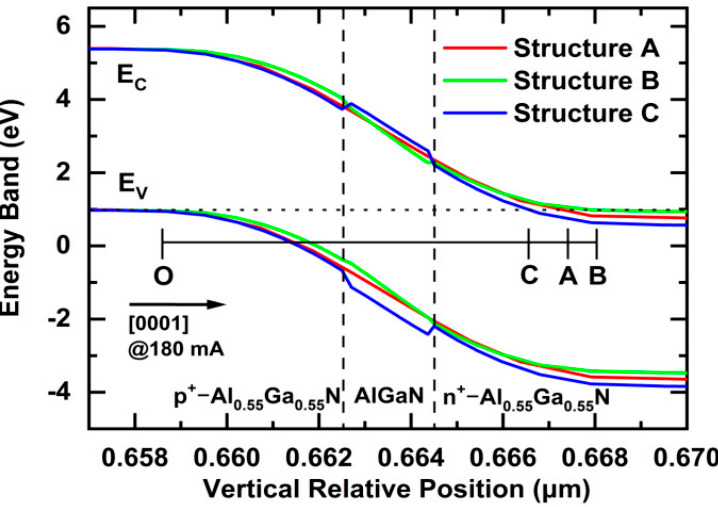
Figure 4. Comparisons of the energy band profiles at a relative horizontal position of 100 µ m in the TJs of LEDs (300 × 300 µ m 2 ) in Structures A, B, and C at a current of 180 mA. Figure 5a shows a comparison of the hole concentration distributions along the vertical direction at a relative horizontal position of 100 µ m in the MQWs of the LEDs for Structures A, B, and C, at a current of 180 mA. The hole concentrations along the vertical direction in the MQWs are in the following order: Structure C > Structure A > Structure B. The high hole concentration in the MQWs in Structure C comes from the enhanced lateral current spreading in the